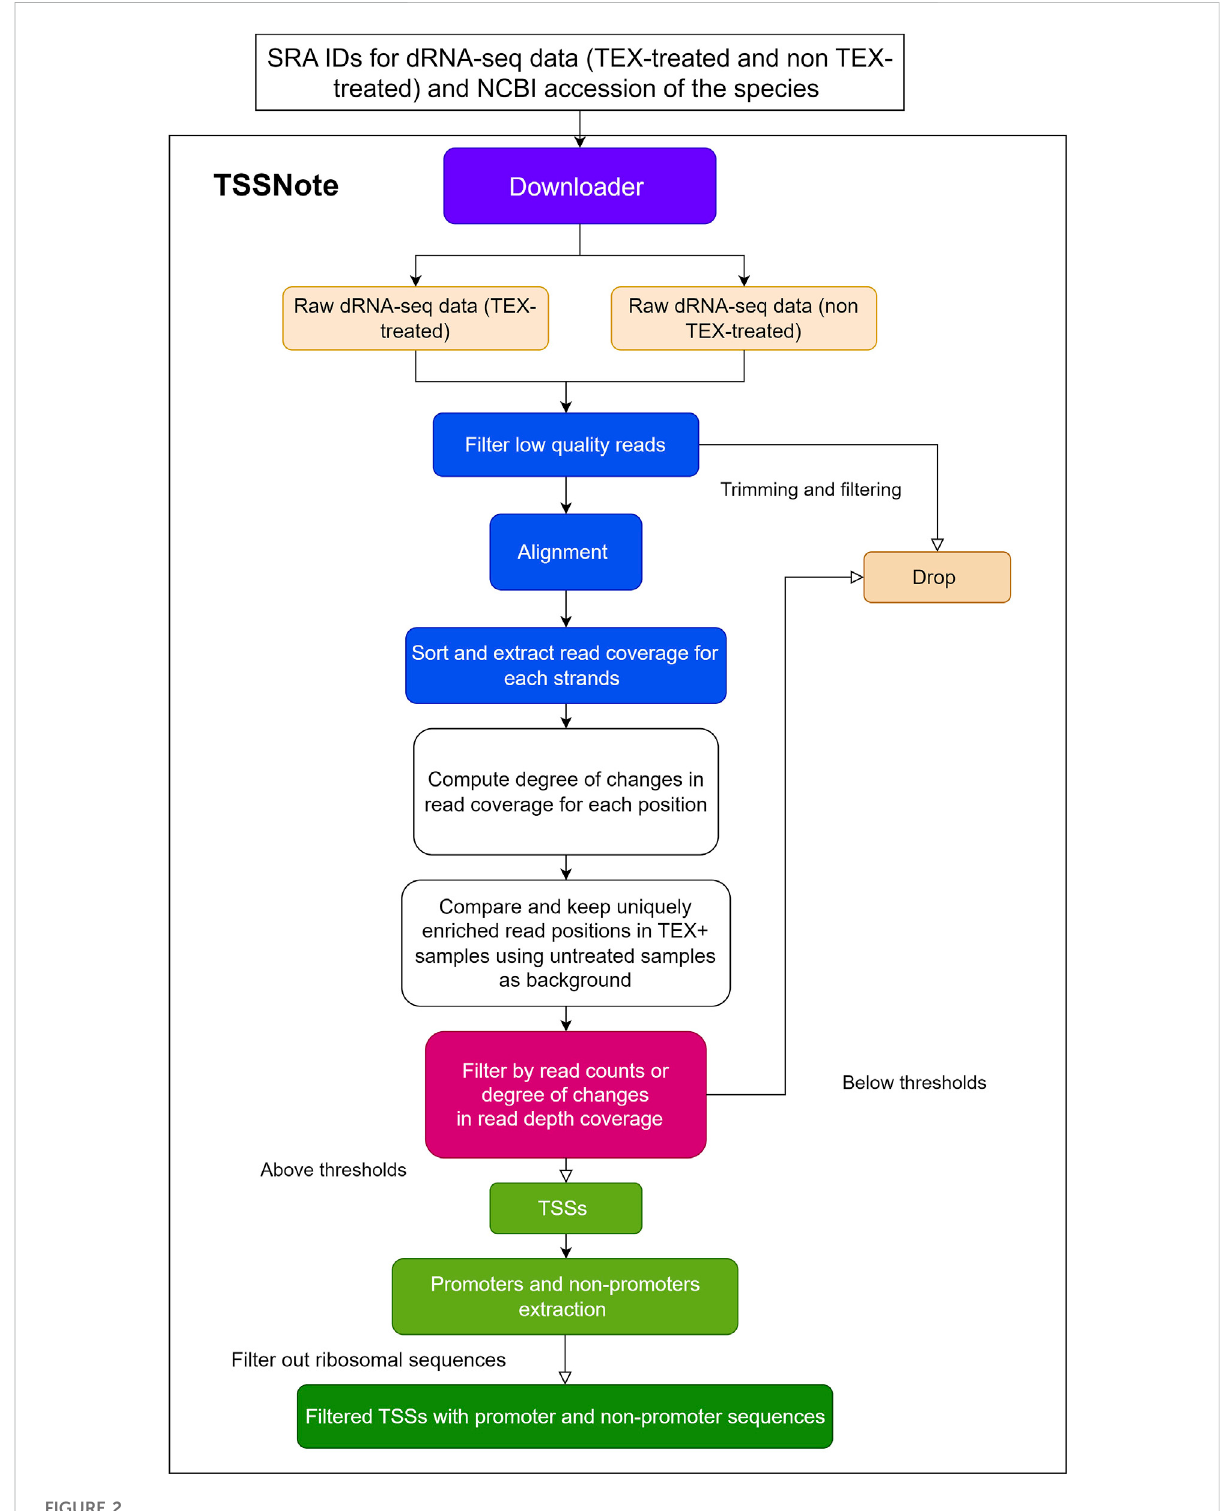
FIGURE 2 Detailed fl owchart of TSSNote operation to extract TSSs, promoters, and non-promoter